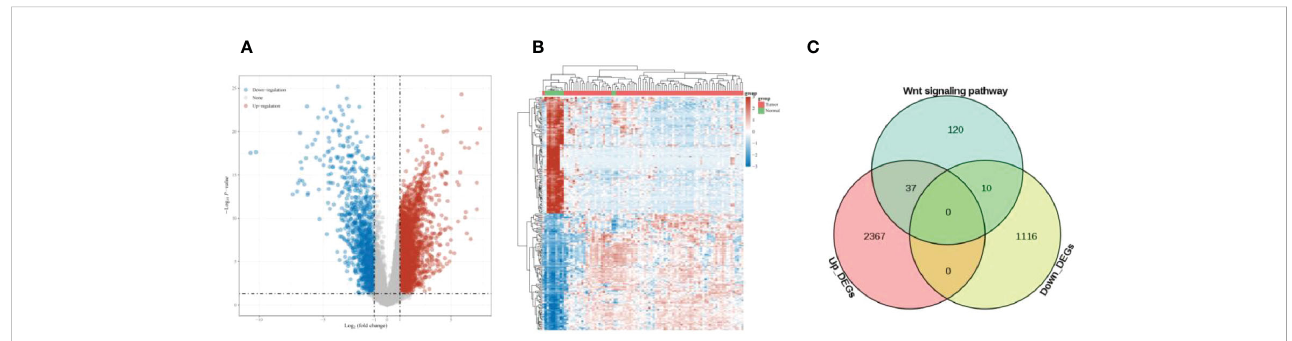
FIGURE 1 Differential expression analysis (A) Volcano plot showing DEGs of ESCC; (B) Heat map showing the distribution of DEGs of ESCC; (C) Venn diagram, overlapping genes were obtained.